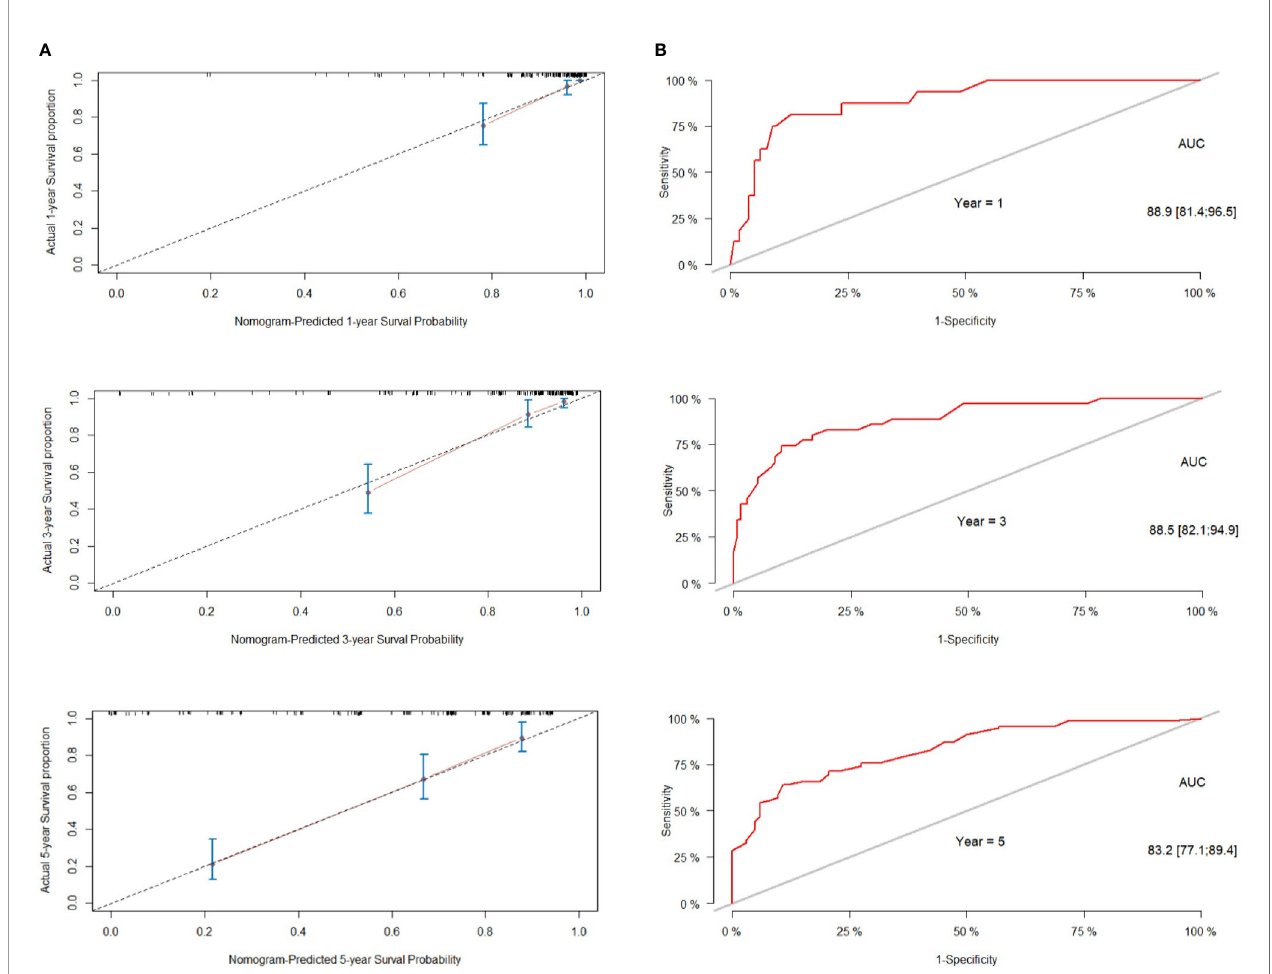
FIGURE 4 | Performance of the nomogram for predicting tumor recurrence or progression. (A) calibration curve of the nomogram. (B) The predictive performance of the nomogram was assessed by receiver operator characteristics (ROC) analysis and area under the curve